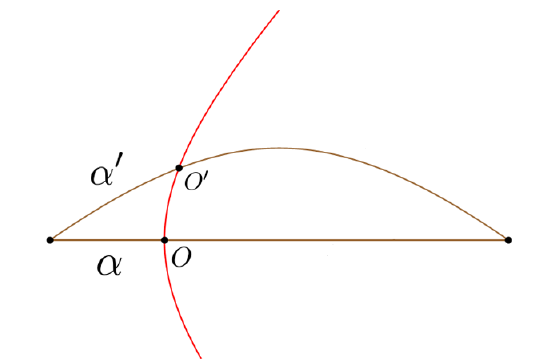
Figure 4 . The red line consist of all the points O 0 that keeps s A 0 ( (cid:11) 0 ) = s A ( (cid:11) ). The red line is the modular (cid:13)ow line according to the property